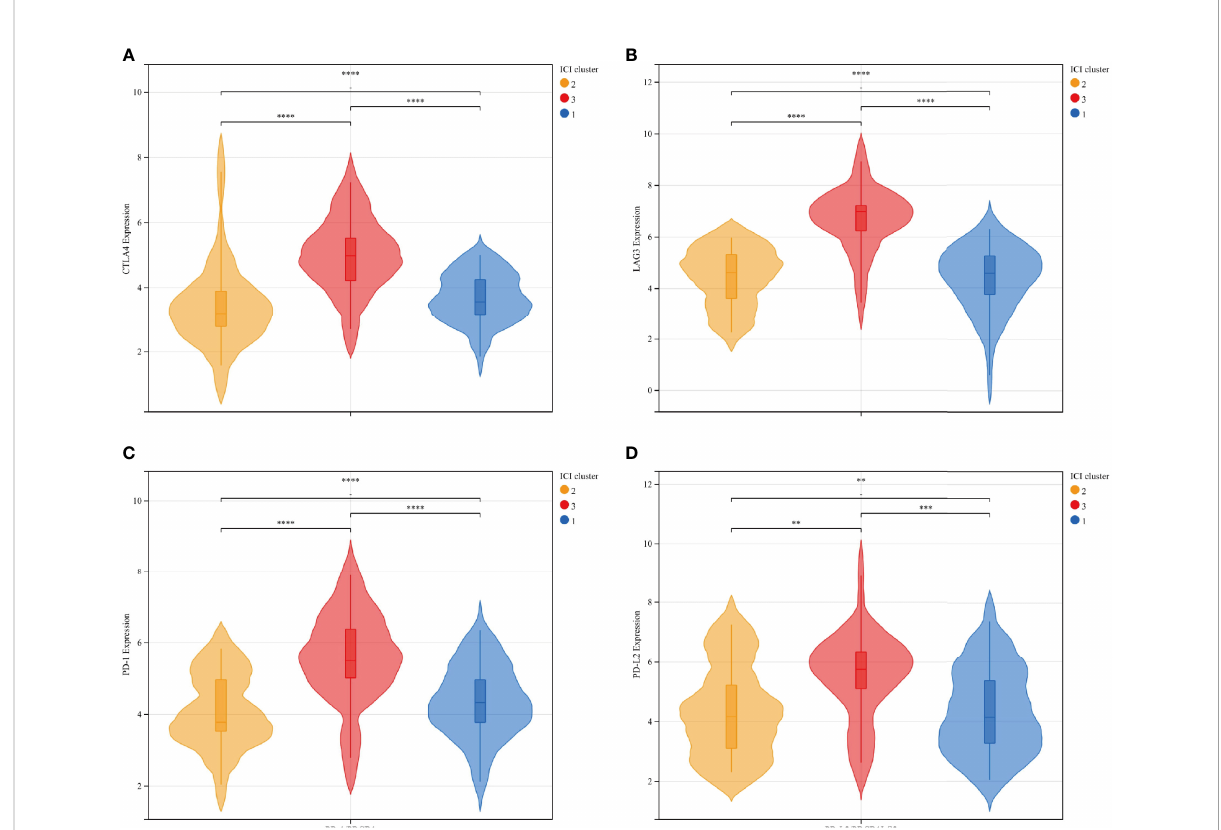
FIGURE 3 The expression differences between immune checkpoint-related genes and ICI subtypes were represented by a violin plot: CTLA4 (A) , LAG3 (B) , PD-1 (C) , and PD-L2 (D) : There was a signi fi cant statistical difference among the three groups. Among the four independent genes, ICI cluster C exhibited signi fi cantly higher expression than ICI clusters A and B, and the average expression of ICI cluster B was relatively lower than ICI cluster (A) ICI clusters: 1-blue-A, 2-yellow-B, 3-red-C. ****p<0.0001, ***p <0.001, **p <0.01, and *p